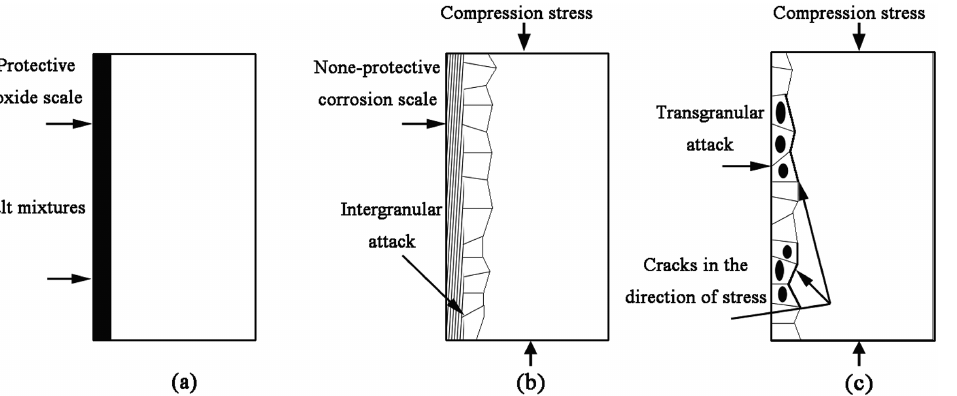
Figure 12: A schematic illustration based on present findings showing the process of compression creep cracks initiation and growth in the 12Cr1MoV alloy in hot corrosion